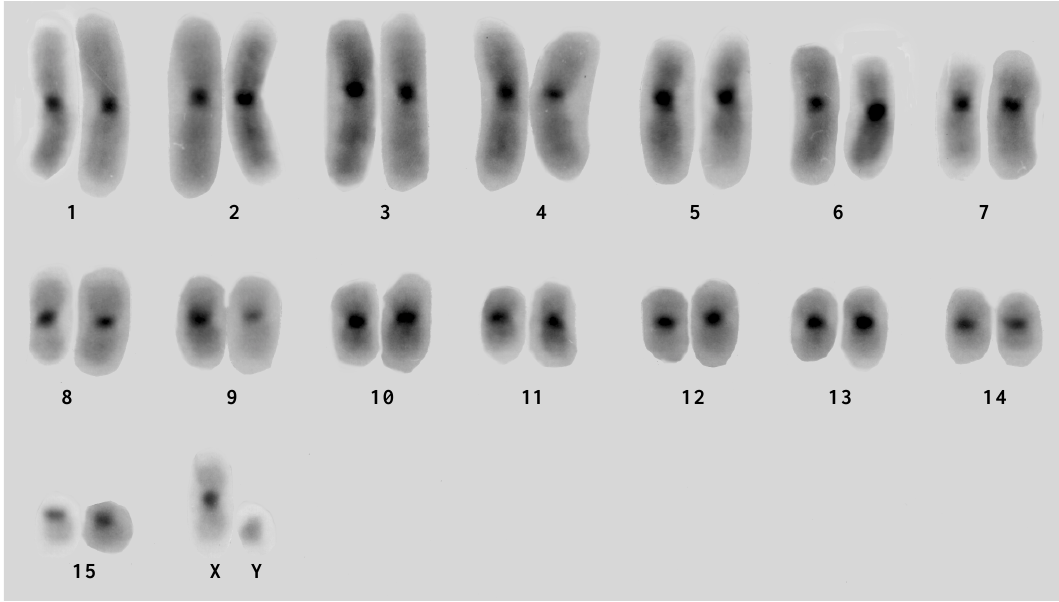
Figure 2 - C-banding pattern of Phyllostomus hastatus .